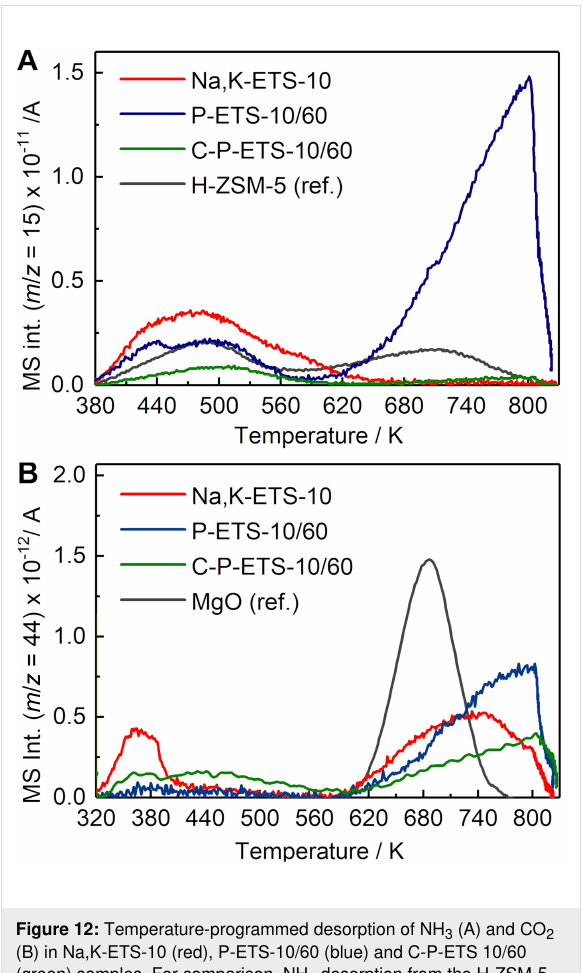
Figure 12: Temperature-programmed desorption of NH 3 (A) and CO 2 (B) in Na,K-ETS-10 (red), P-ETS-10/60 (blue) and C-P-ETS 10/60 (green) samples. For comparison, NH 3 desorption from the H-ZSM-5 zeolite with Si/Al = 27 and a known acid site density used as a refer- ence is presented by the grey line. The curve of MgO was used as a reference in